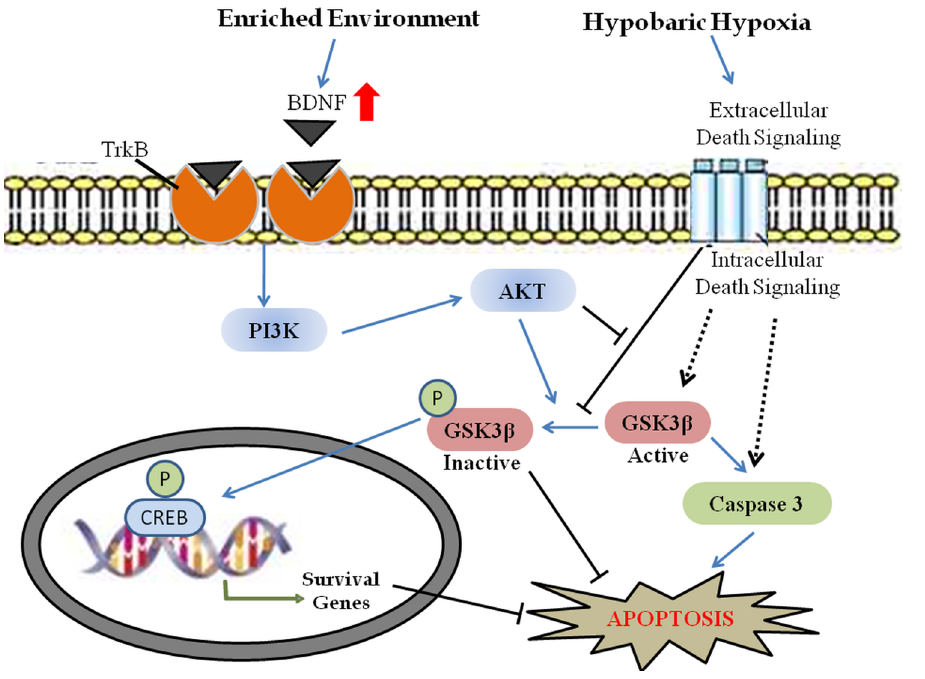
Figure 6. Schematic diagram of signaling events in enriched environment mediated neuroprotection during hypobaric hypoxia.